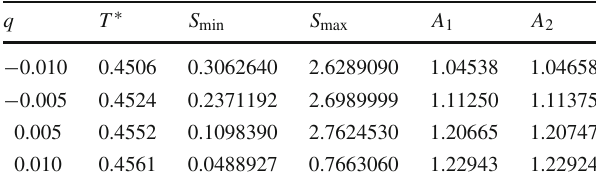
Table 2 Check of the Maxwell equal-area construction in the T – S